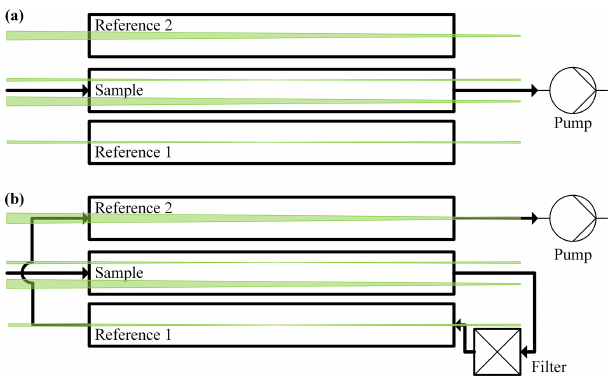
Figure 8. MSPTI signal dependence on the heating time for 1 part per million (ppm) of NO 2 in synthetic air. For shorter heating times, the PTI signal is linearly dependent on the heating time (dotted line). Error bars represent 1 standard deviation (SD) of the 10s in- tegrated